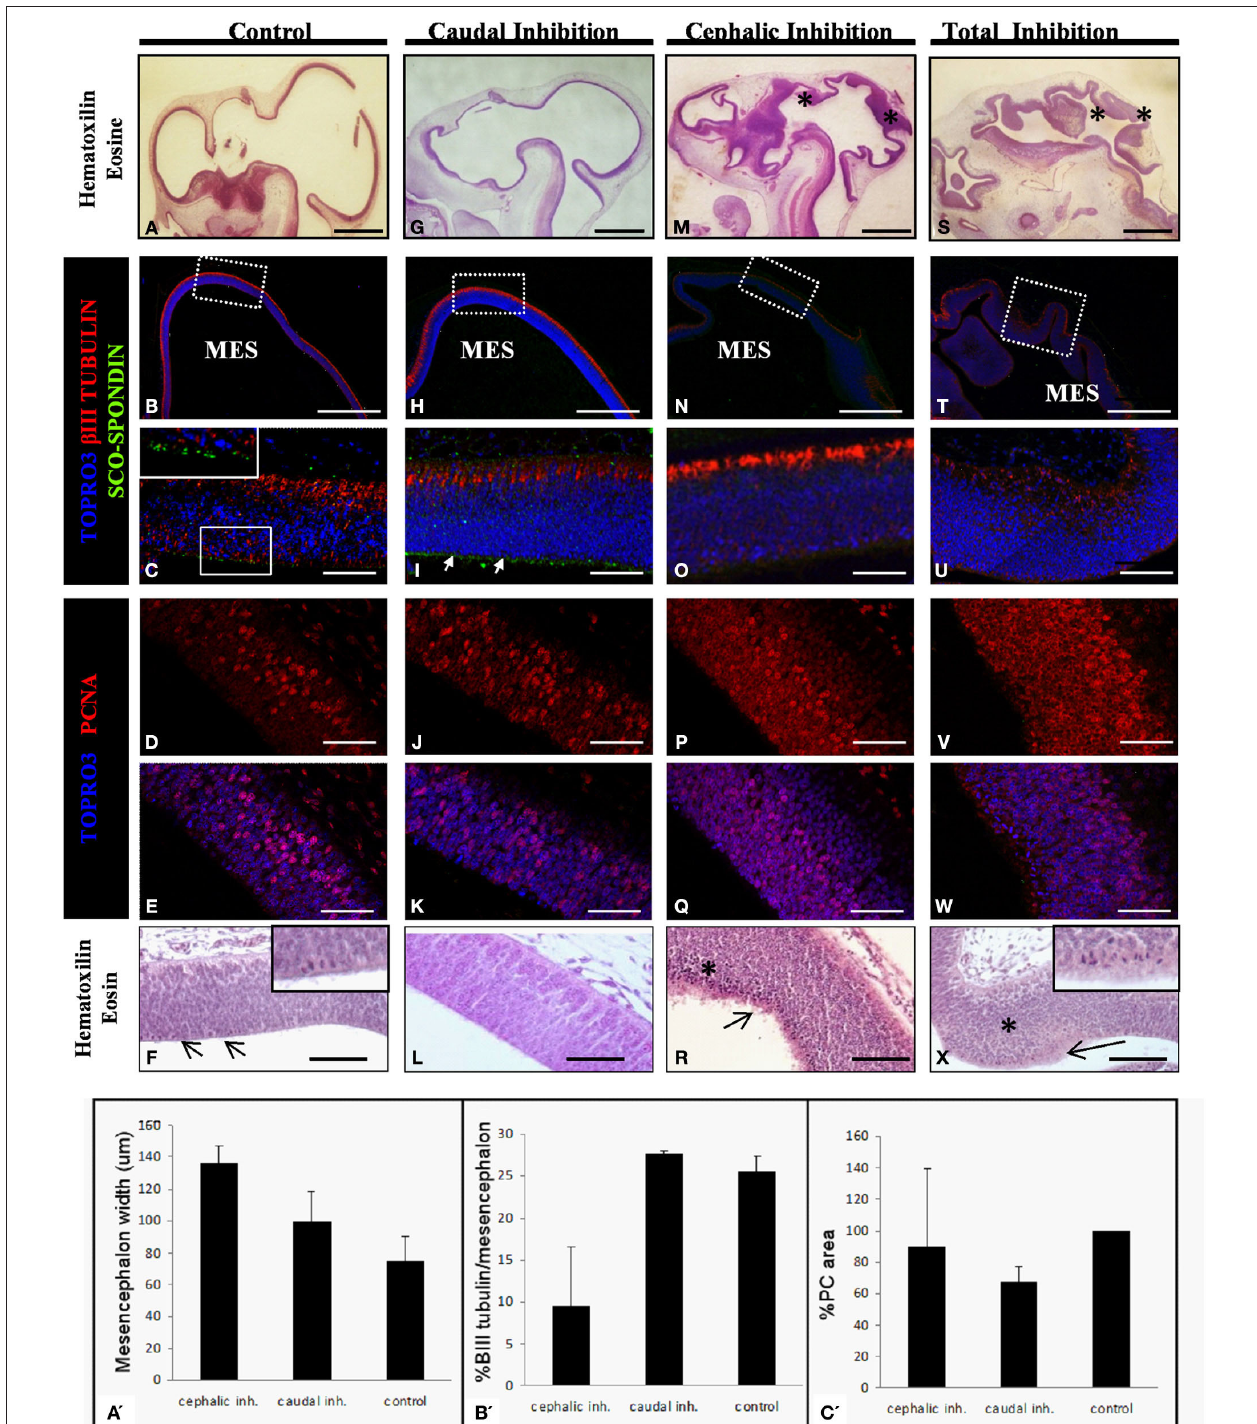
FIGURE 7 | Effect of the SCO-spondin loss of function on mesencephalic development. The panels show sagittal sections of mesencephalon of HH29 chick embryos with partial or total inhibition of SCO-spondin. (A–F), Control embryos; (G–L) , caudal inhibition; (M–R) , cephalic inhibition; (S–X) , complete inhibition of SCO-spondin; (A,F,G,L,M,R,S,X) , Hematoxilin-Eosin staining; (B,C,H,I,N,O,T,U) , Immunohistochemistry for β III tubulin and SCO-spondin counterstained with TOPRO3. Inset in (C) and arrows in (I) show the apical